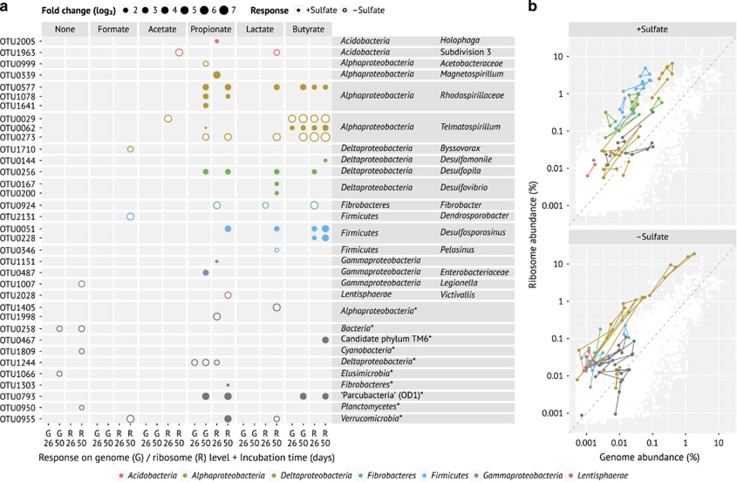
OTUs responding to individual carbon degradation intermediates. (a) OTUs responding positively to sulfate stimulation (+Sulfate) and/or unamended conditions (−Sulfate) at the 16S rRNA cDNA (i.e., ribosome) or gene (i.e., genome) level. OTUs 0062+0273, 0346 or 0029+0062 exhibited both +Sulfate and −Sulfate responses in propionate-, lactate- or butyrate-amended microcosms, respectively (stronger response indicated). Taxonomic classification indicates phyla (classes for Proteobacteria) and the highest taxonomic level resolved by the RDP classifier. OTUs without RDP classification at class level (marked with asterisks) were assigned tentative classifications by the SINA online classifier (Pruesse et al., 2012) using a minimum identity threshold of 0.75. (b) Relationship of relative genome and ribosome abundance per responsive OTU at time points with significant abundance shifts. Lines connect replicate microcosms for each OTU (abundances of zero not shown). White circles represent 10 000 randomly selected data points (>0.0005% relative abundance).